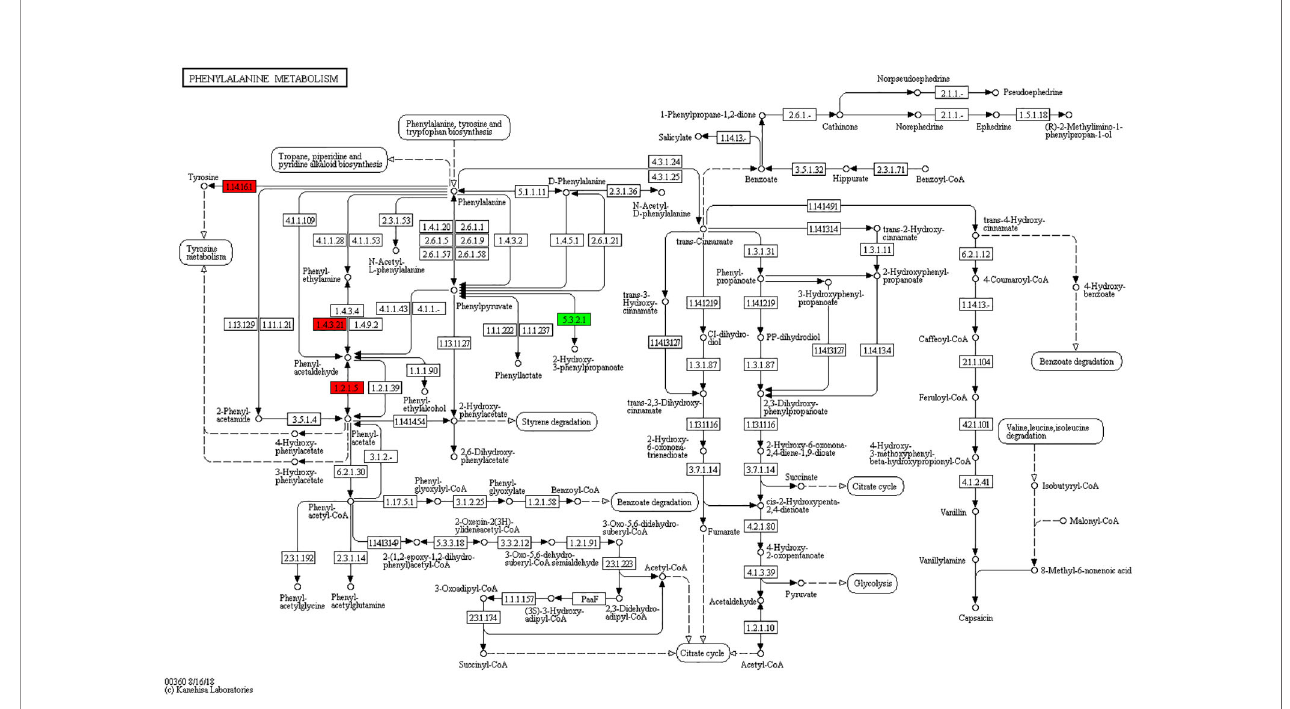
FIGURE 8 | Network of phenylalanine metabolic pathways.